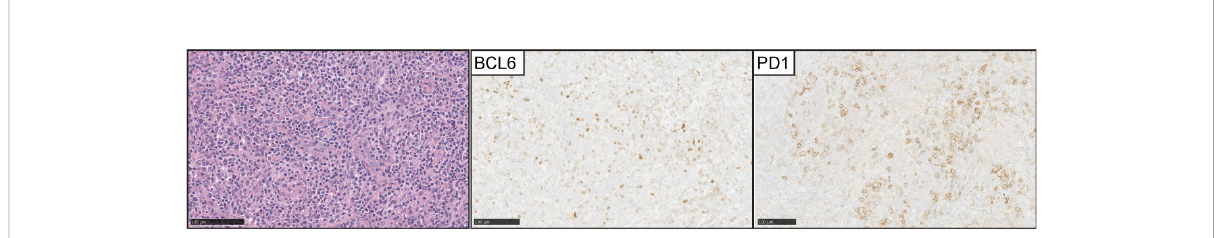
FIGURE 5 Angioimmunoblastic T-cell lymphoma (AITL). (Left panel) H&E images show characteristic branching of post-endothelial venules and adjacent lymphocytes with clear cell cytoplasm. Expression of BCL-6 and PD1 is detected in the neoplastic T-cell lymphocytes in the majority of